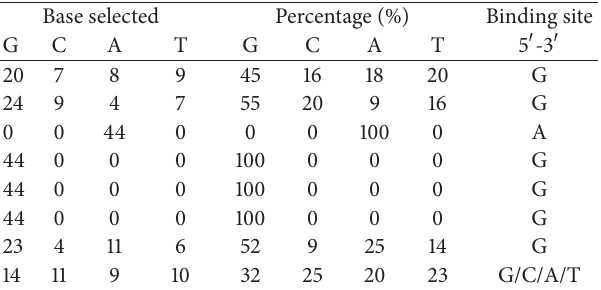
Table 1: Derivation of the ZNF191(243-368) consensus binding